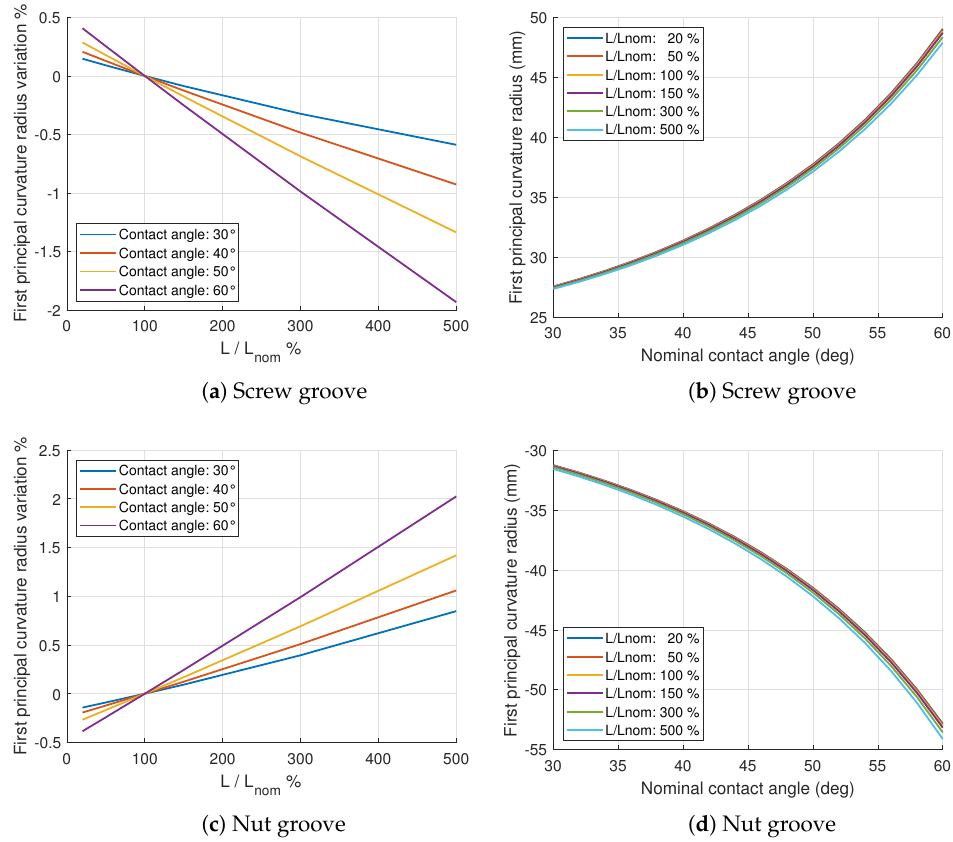
Figure 7. First screw shaft and nut curvature variation with respect to the gothic arch parameter L ( a , c ) and to the nominal contact angle ϕ 0 ( b , d ) for a ball screw with r m = 25 mm, r b = 3.5 mm, p = 80 mm, ϕ 0 = 45 ◦ and H nom = L nom = 0.0693